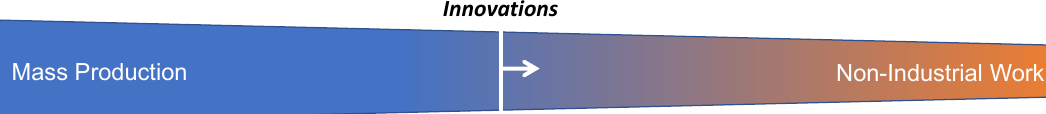
Figure 3 . Relation between Mass Production, Innovation and Non-Industrial